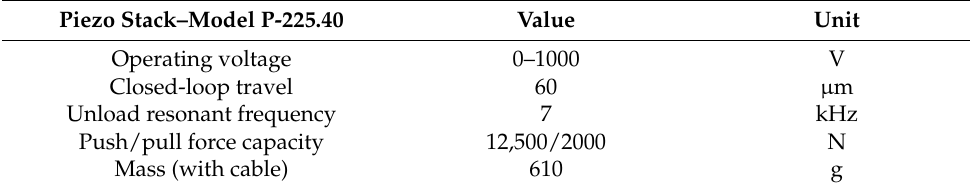
Table 1. Operating parameters of the PZT actuator. Piezo Stack–Model P-225.40